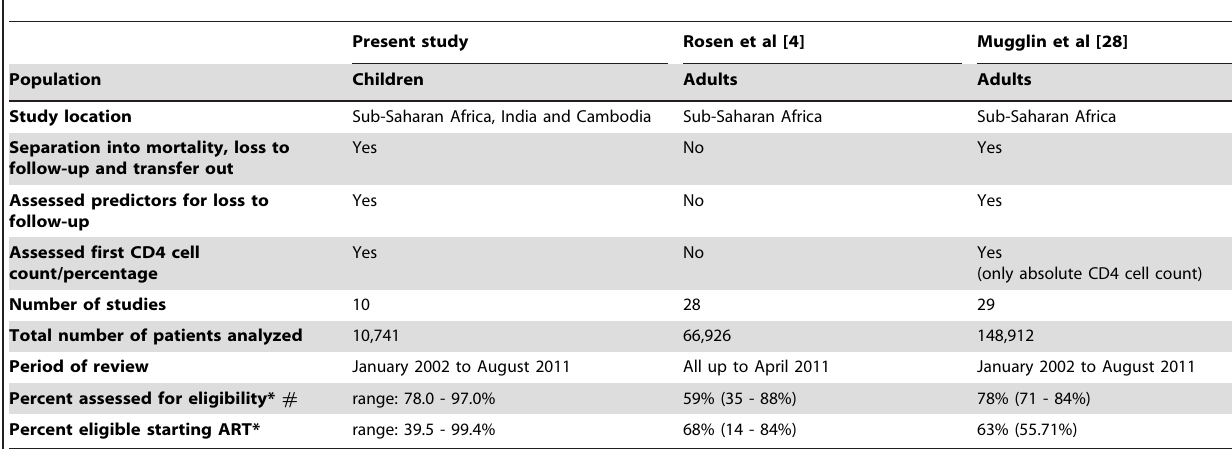
Table 2. Comparison of different systematic reviews about linkage to care in adults and